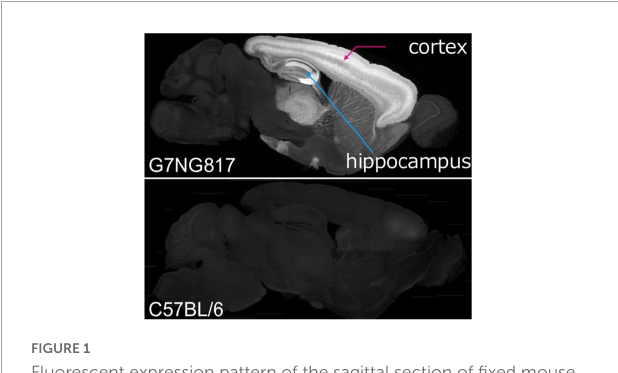
FIGURE1 Fluorescent expression pattern of the sagittal section of fixed mouse brains. (Top) G7NG817 line transgenic mouse, (bottom) C57BL/6 line wild type mouse as a control [modified from Monai et al. (2016)].